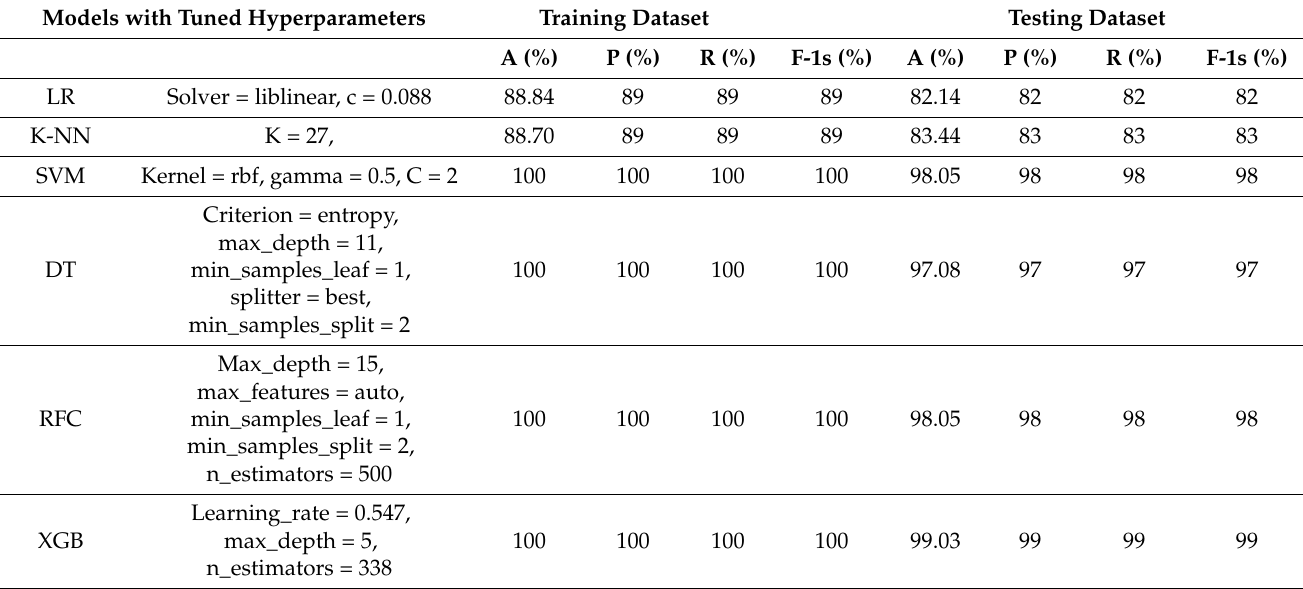
Table A4. For the training set and test set, classification models were evaluated and compared using a hyperparameter tuning strategy.